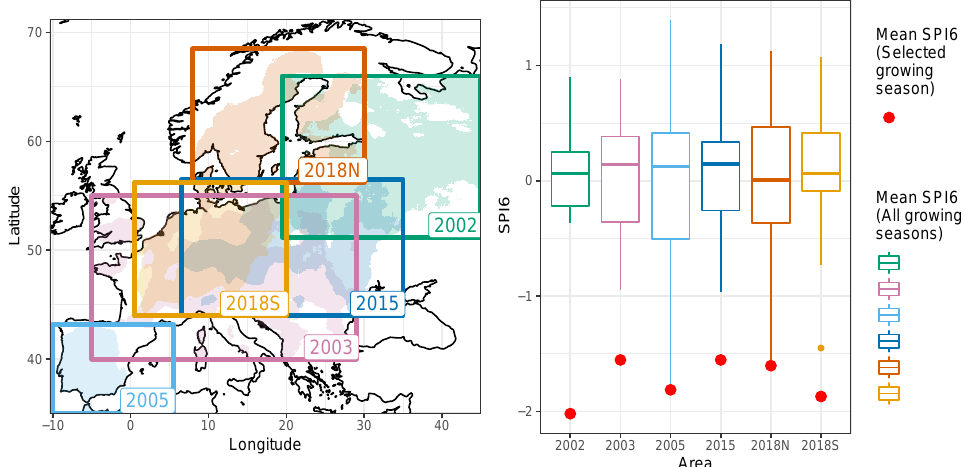
Figure 2. Properties of the selected summer droughts. Left : the location and spatial extent, right : SPI6 over the selected growing season (red), compared to the distribution of SPI6 in the remaining growing seasons for the same